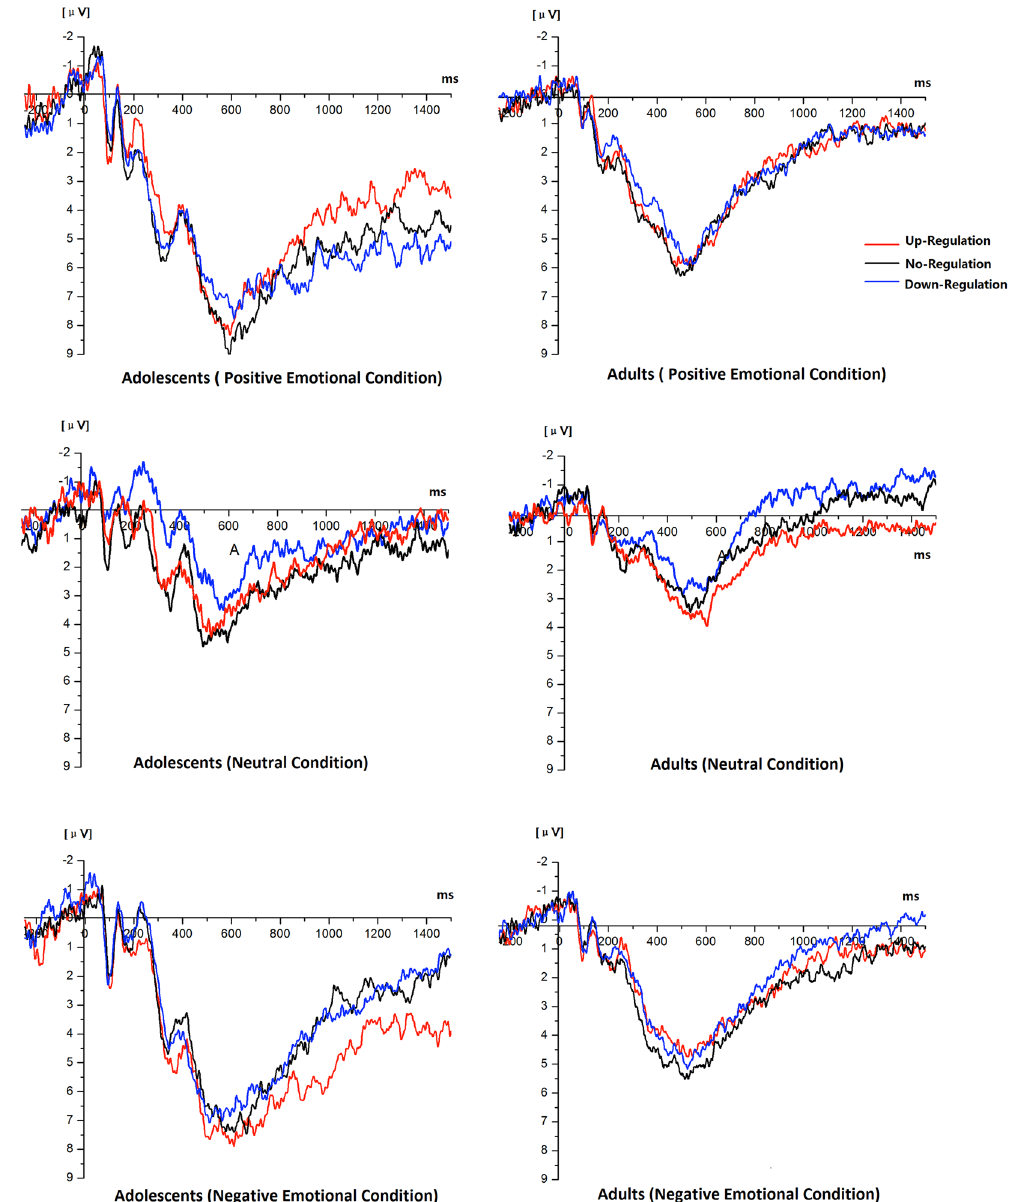
Figure 3. The ERP wave forms at the medial-posterior recoding sites for different experimental conditions between adolescents and